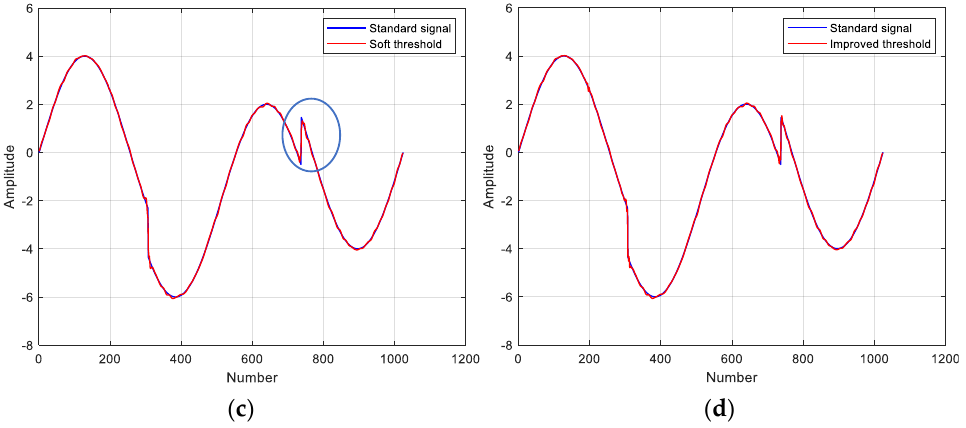
Figure 4. Comparison of noise reduction results with different threshold functions: ( a ) standard signal and noisy signal; ( b ) hard threshold function for noise reduction, SNR = 36.9816; ( c ) soft threshold function for noise reduction, SNR = 35.1864; ( d ) improved threshold function for noise reduction, SNR = 37.0567.